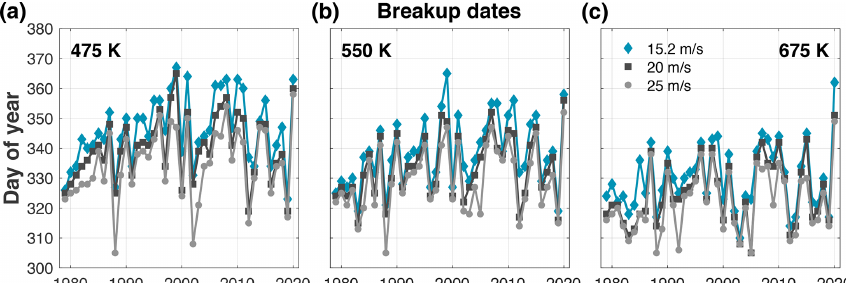
Figure 10. Interannual evolution of Antarctic polar vortex breakup dates over the period 1979–2020. Panels from (a) to (c) show onset dates at 475, 550, and 675K. Light gray, dark gray, and blue curves represent onset dates for the 15.2, 20, and 25ms − 1 wind threshold values,